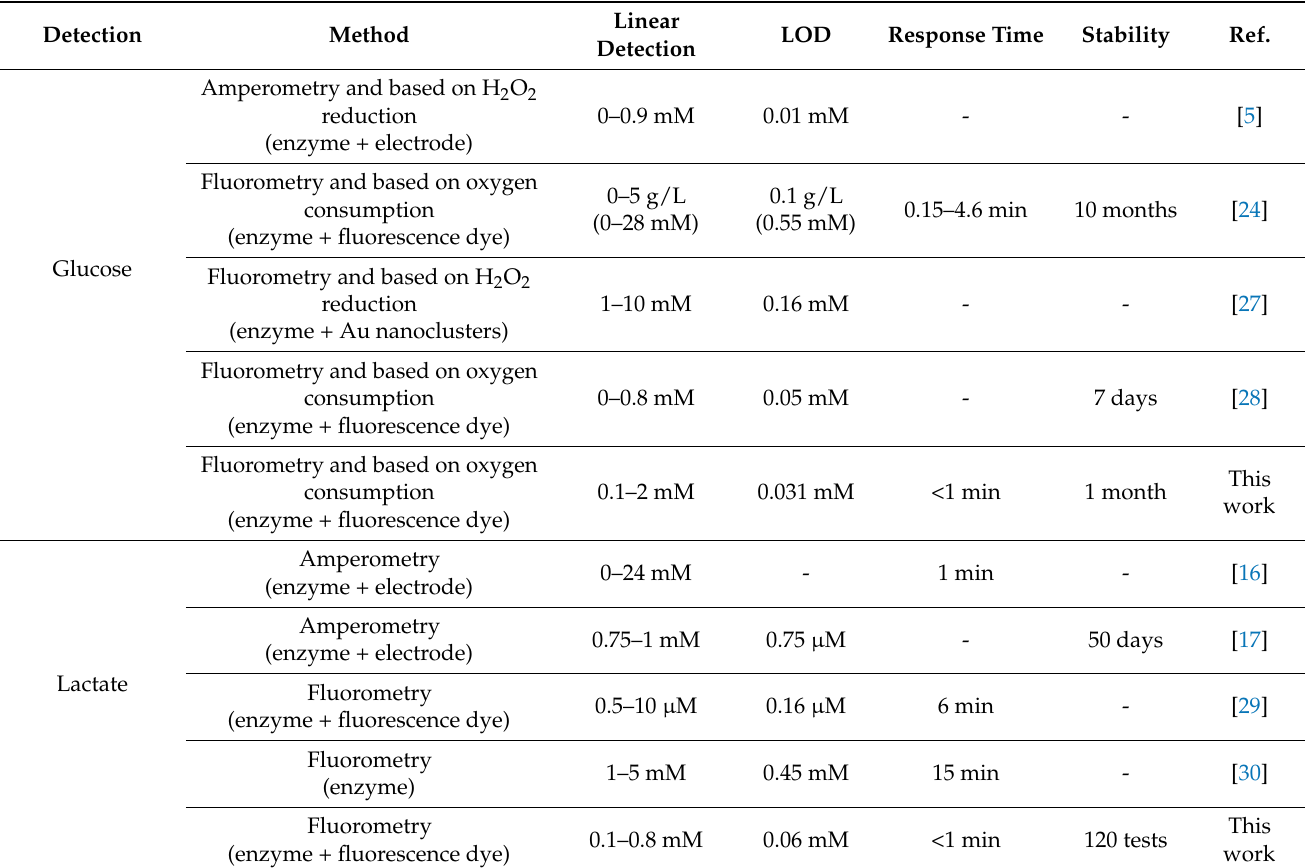
Table 1. Comparison of some analytical parameters of glucose and lactate